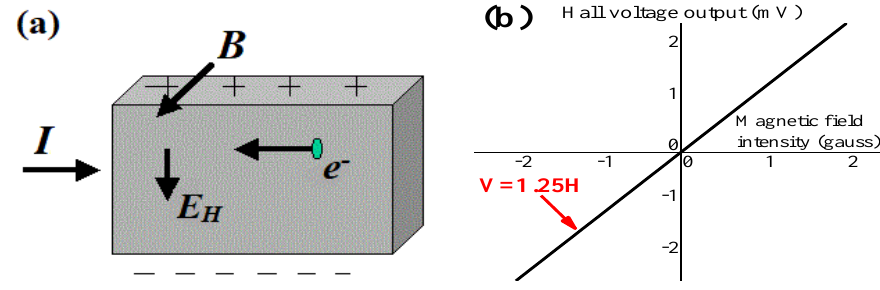
Figure 2. ( a ) Hall effect schematic diagram and ( b ) linear output of Hall effect sensors.